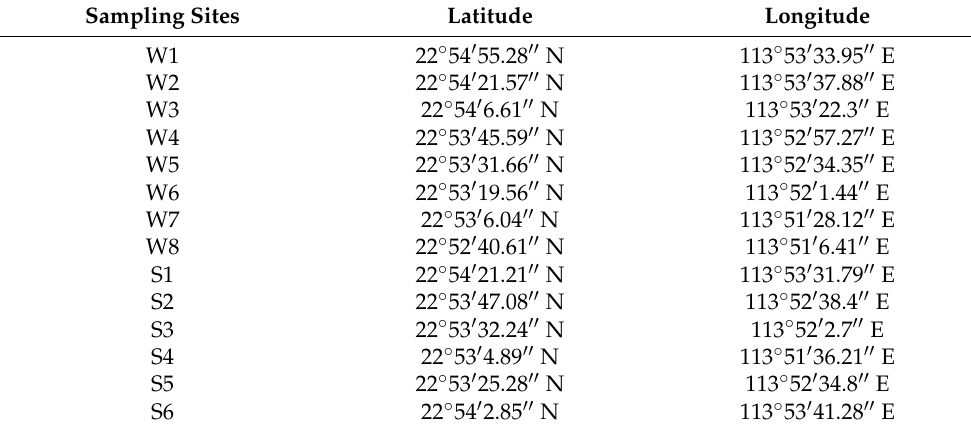
Figure 1. The geographic location of sampling sites from the surface water and the surface sediments of Songshan Lake. Table 1. Location of sampling sites in the studied areas.